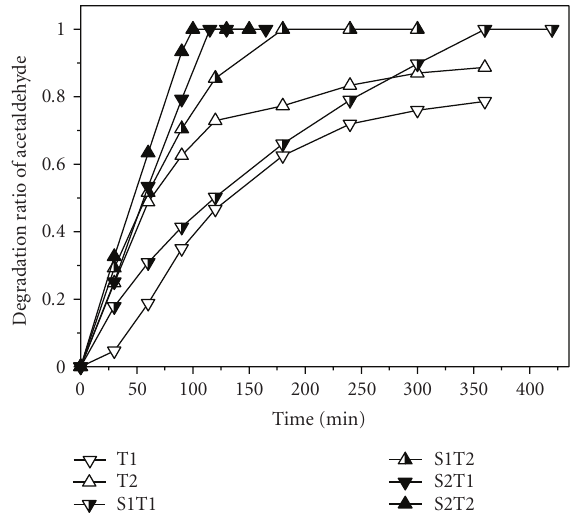
Figure 8: Time courses of the photocatalytic decomposition of gaseous acetaldehyde over various TiO 2 and TiO 2 /SiO 2 films immobilized on foam nickel under UV-light irradiation ( λ = 254nm,15W).